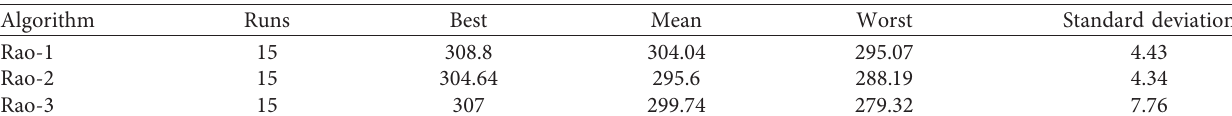
Table 6: Best, mean, and worst objective function values obtained corresponding to the optimal solution using Rao algorithms for the CFRO system problem. Algorithm